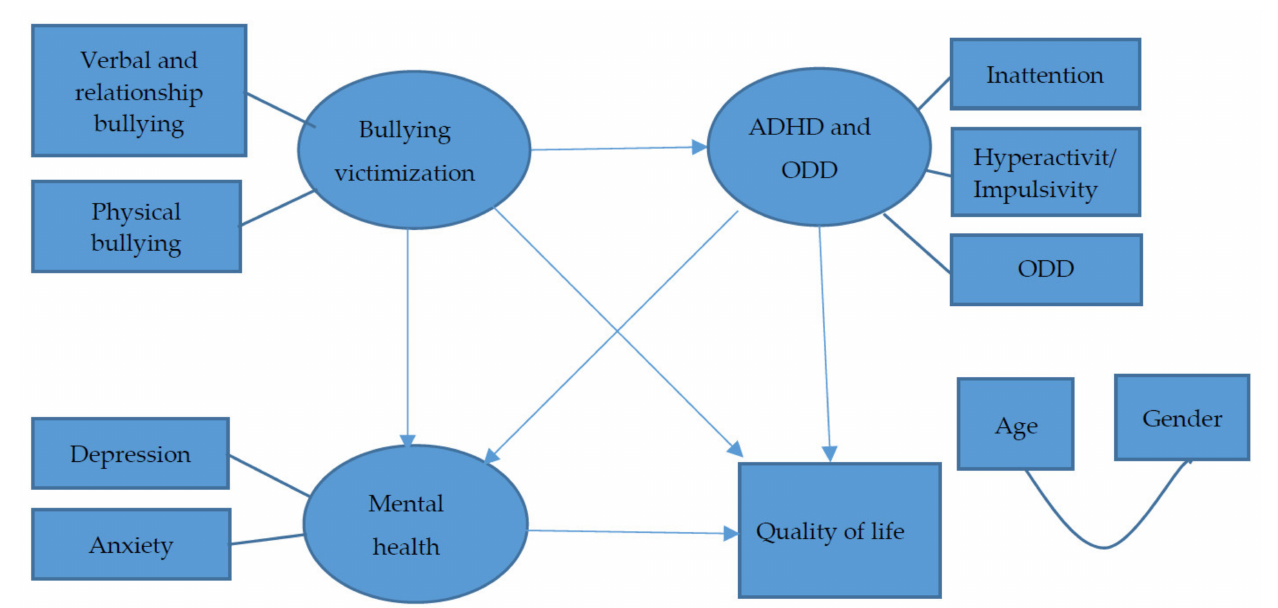
Figure 1. Hypothesized model. ADHD: Attention-deficit/hyperactivity disorder; ODD: Oppositional defiant disorder; Impulsivity: impulsivity subscale of Swanson, Nolan, and Pelham Version IV Scale (SNAP-IV); Inattention: inattention subscale of SNAP-IV; ODD: ODD subscale of SNAP-IV; Depression: total scores of Children’s Depression Inventory- Taiwanese Version; Anxiety: total scores of Taiwanese version of the Multidimensional Anxiety Scale for Children; Verbal and relationship: verbal and relationship subscale of the School Bullying Experience Questionnaire; Physical: physical bullying subscale of the School Bullying Experience